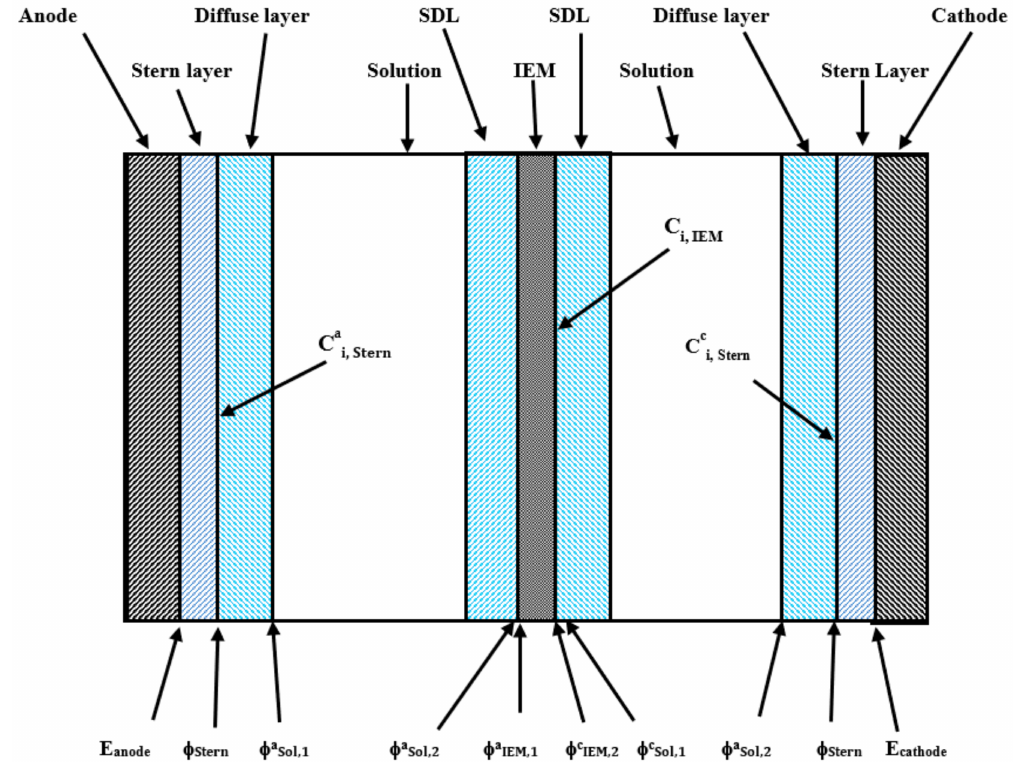
Figure 2. Descriptions of the different sections used to describe the operation of the electrochemical